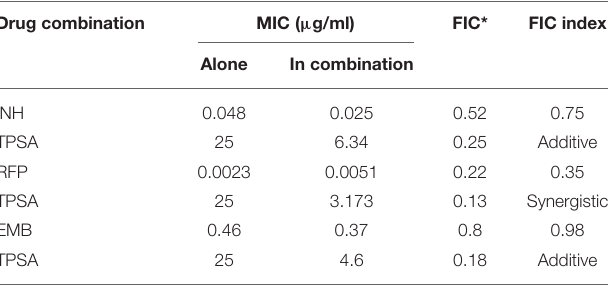
TABLE 2 | Synergy between TPSA and anti-TB first line